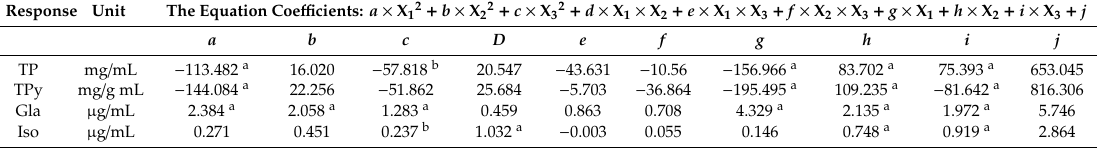
Table 3. Polynomial equations of the models in terms of coded